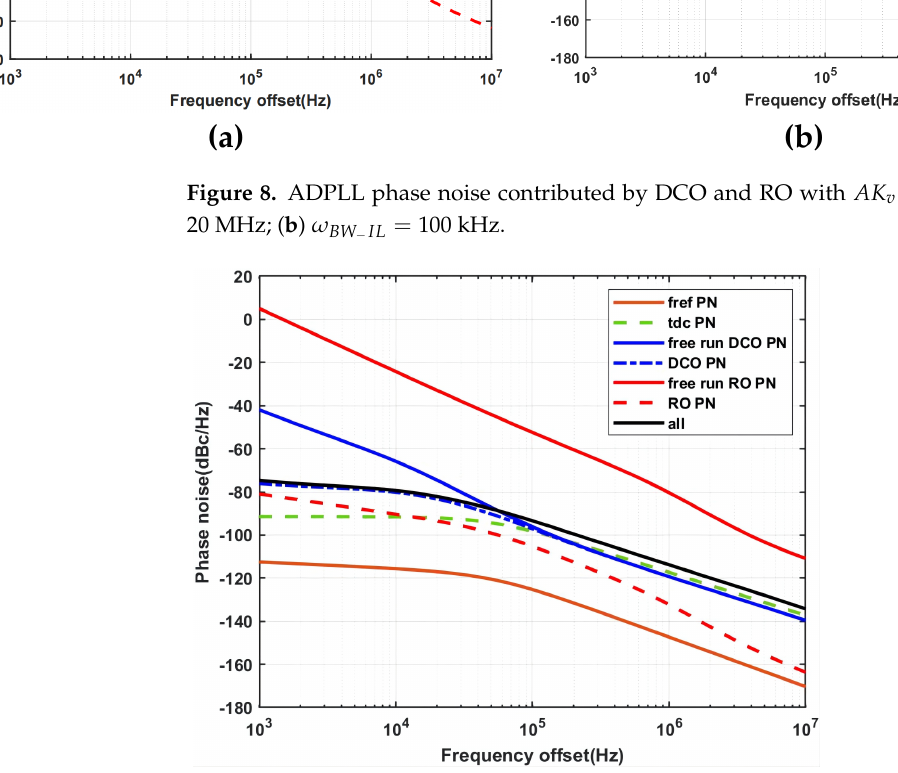
Figure 9. Total phase noise contribution of the proposed